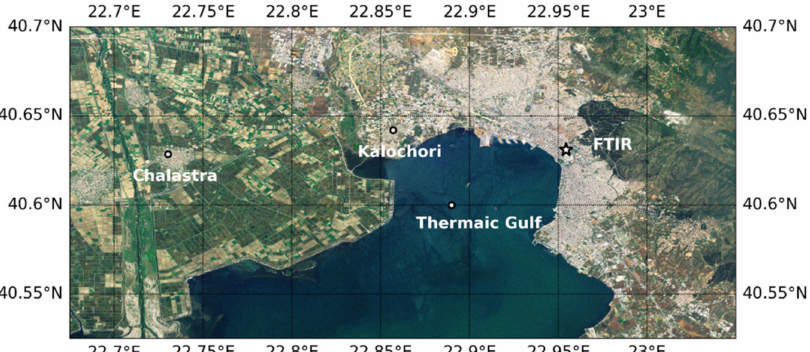
Figure 1. A map showing the location of the FTIR instrument (star) within the Thessaloniki urban area, as well as the location of possible CH 4 sources (rice paddies in the area between Kalochori and Chalastra), and Thermaic